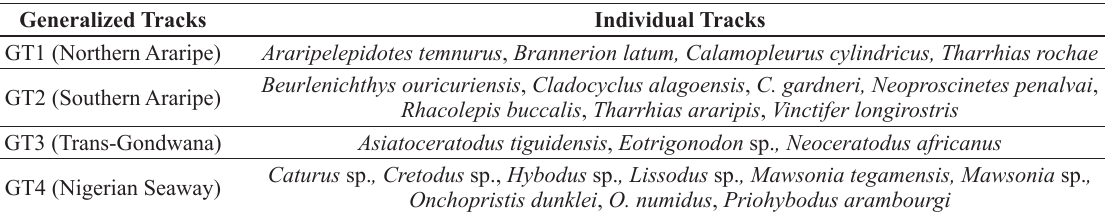
Generalized Tracks (GTs), their respective locations (names) and Individual Tracks. Generalized Tracks Individual Tracks